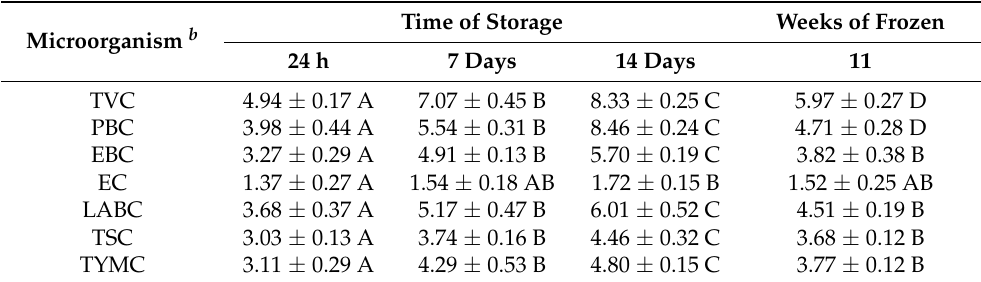
Table 1. Microbiological counts (log CFU/g and % TCV) of a different microbial group of beaver meat samples ( n = 6) a . Microorganism b